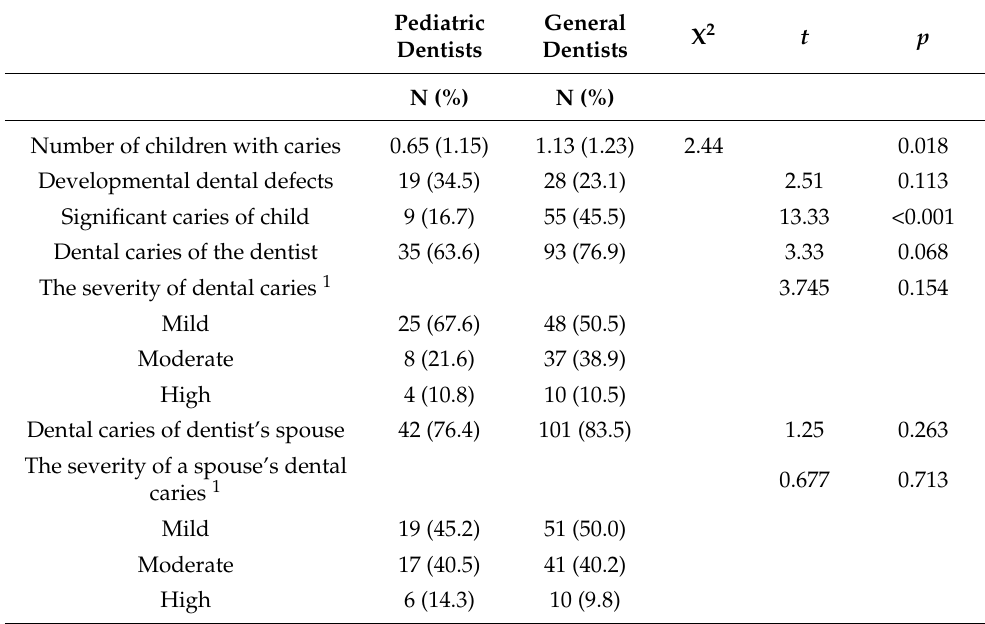
Table 2. Comparison of caries information between pediatric and general dentists’